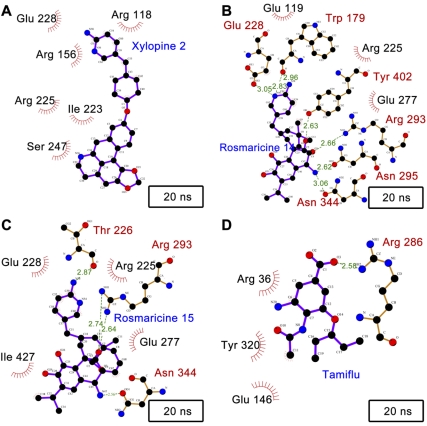
Protein-ligand interactions of TCM candidates and Tamiflu® in N1.H1-ligand interactions following MD are illustrated for (A) Xylopine_2, (B) Rosmaricine_14, (C) Rosmaricine_15, and (D) Tamiflu®. Hydrogen bonds are indicated by green dashed lines between the atoms involved. Amino acids forming H-bonds with the ligand are shown in red. Hydrophobic contacts are represented by arcs with spokes radiating towards the ligand atoms they contact. The contacted atoms are shown with spokes radiating back.